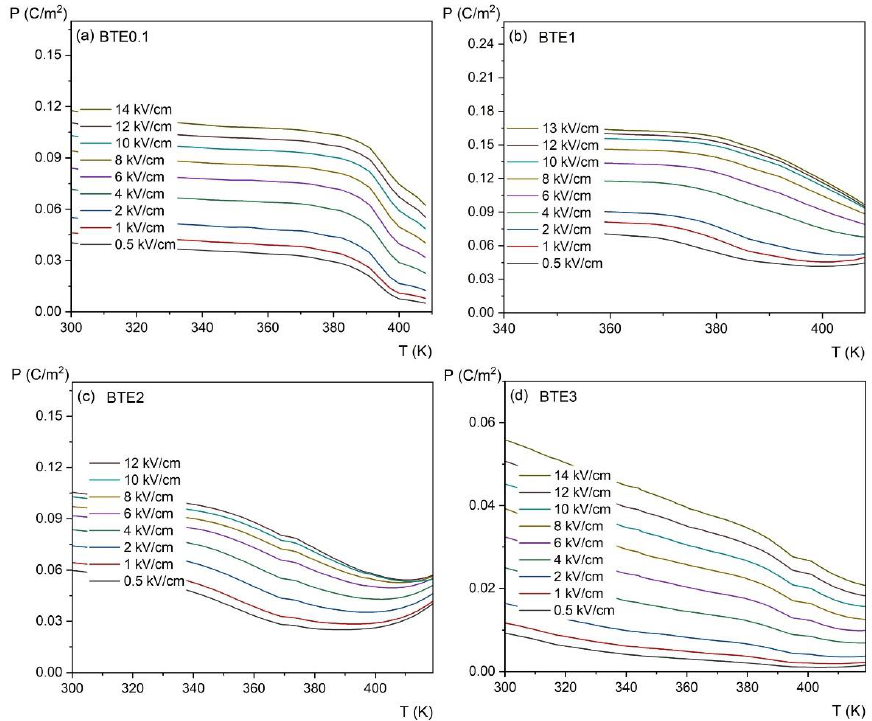
Figure 11. Temperature dependence of the spontaneous polarization measured for BTEx ceramics: ( a ) BET0.1, ( b ) BTE1, ( c ) BTE2, and ( d ) BTE3 measured at different electric